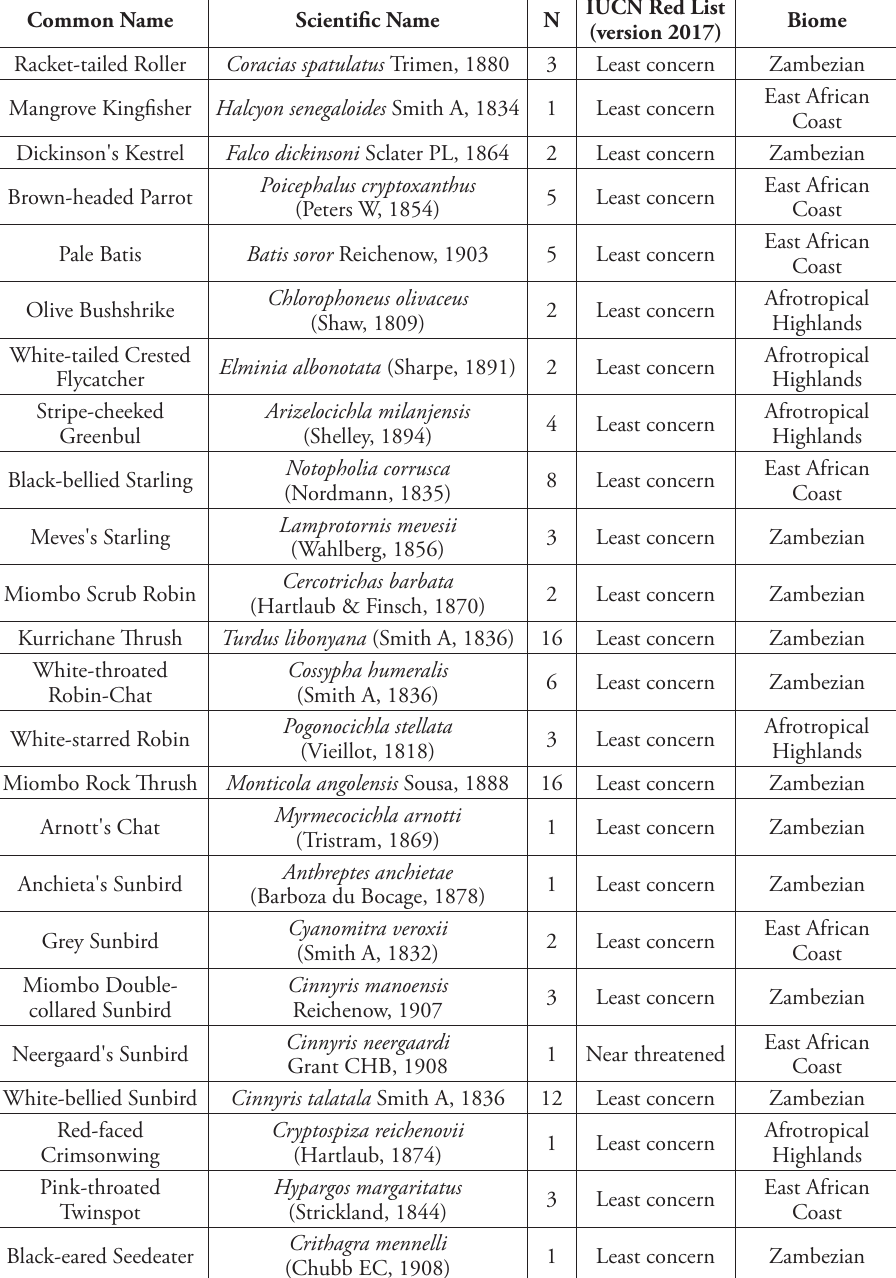
Table 1. Biome-restricted species (Parker 1999) that occur in Mozambique and are represented in the IICT-ULisboa collection. The taxonomic nomenclature follows the International Ornithological Council Bird List v6.1 (Gill and Donsker